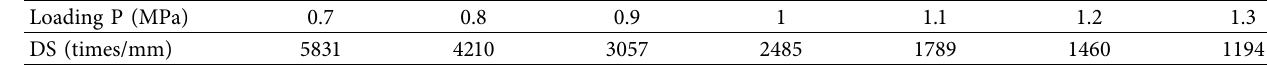
Table 5: Relationship between loading pressures and DS.